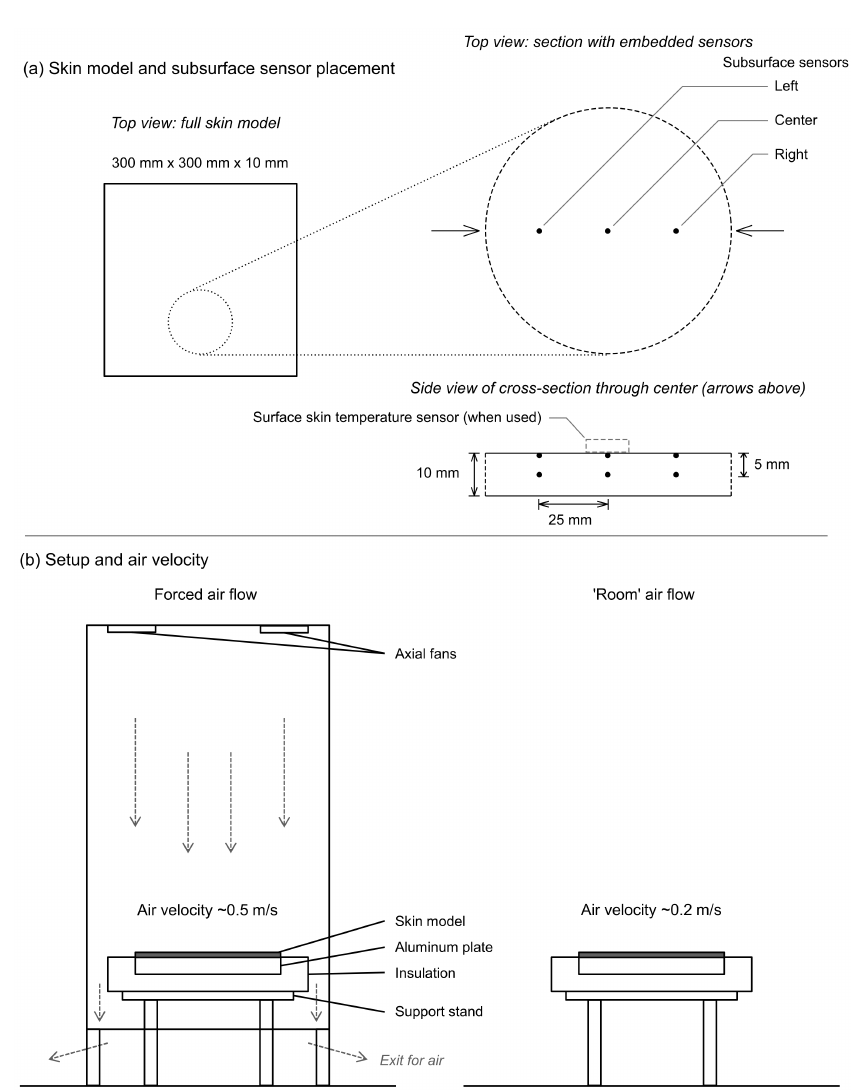
Figure A1. Setup of the silicone elastomer thermal skin model ( a ) and the overall setup for con- trolling the temperature (via water-perfused aluminum plate) and air velocity (fans or no fans ( b )). The reference temperature used during this experiment was from the center of the three directly subsurface temperature sensors embedded in the skin simulant ( a ; see description in Appendix A.2, below). When a surface skin temperature sensor and/or attachment was used, it was positioned directly above the middle subsurface temperature sensor. The second row of sensors within the silicone elastomer skin (5 mm beneath the surface) enabled the estimation of temperature gradient through the